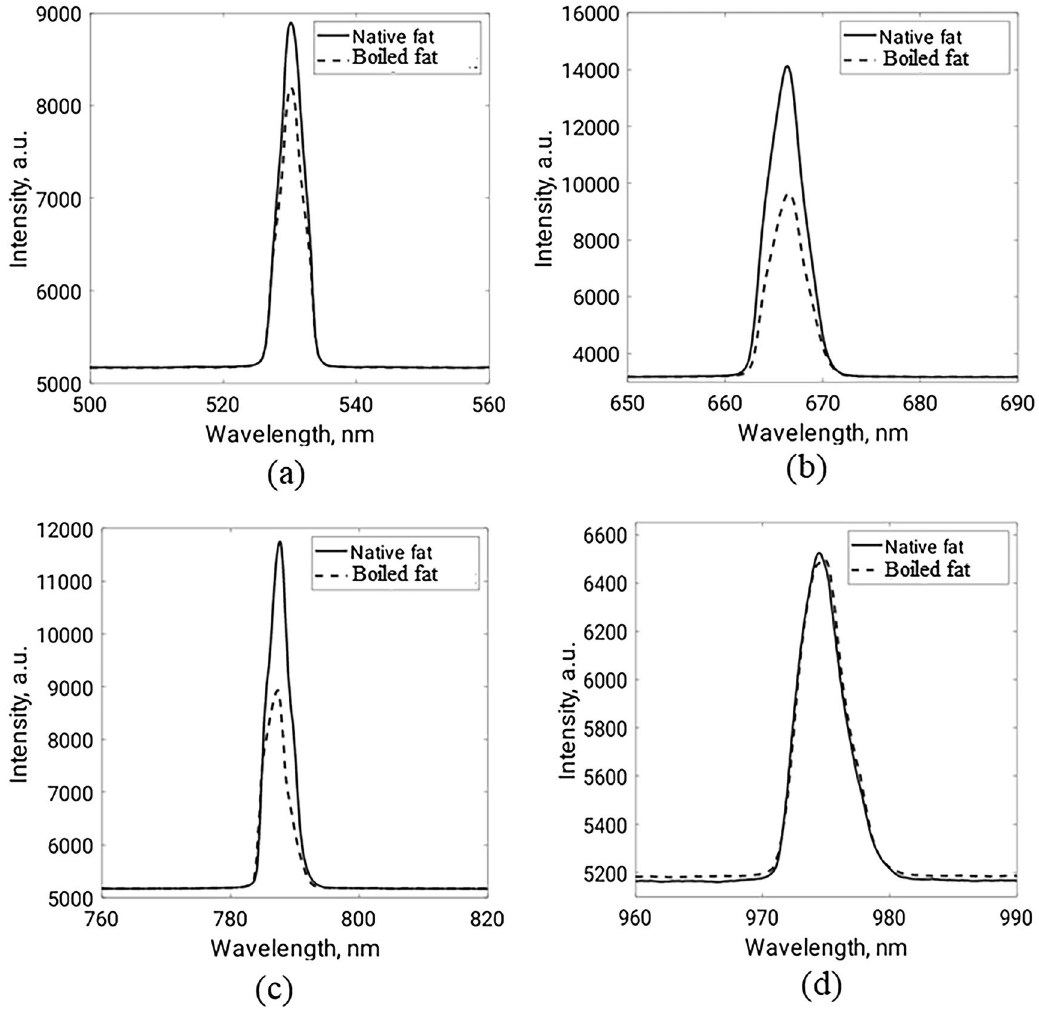
Figure 14. Total transmitted light of fat samples at ( a ) 532 nm, ( b ) 660 nm, ( c ) 780 nm, and ( d ) 980